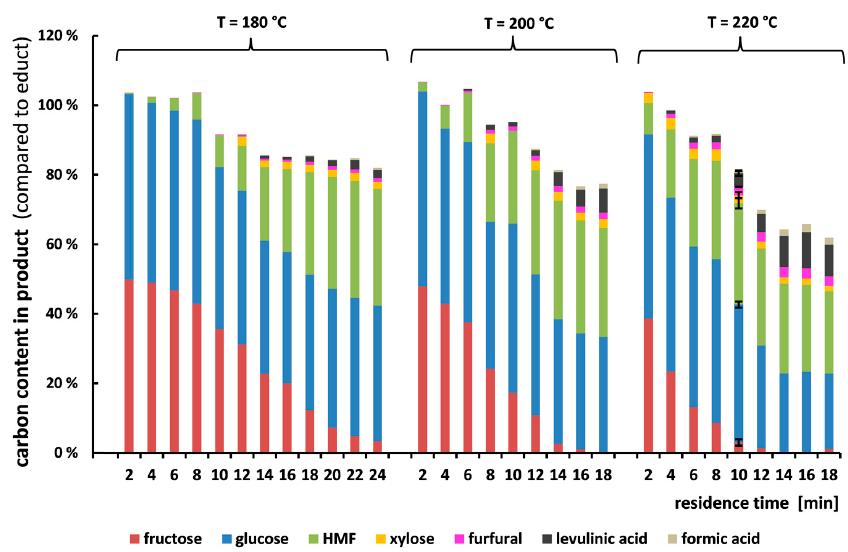
Figure 4. Carbon composition after acid-catalyzed conversion of sucrose at different residence times and reaction temperatures (T). The carbon input of sucrose is represented by 100%. Feedstock contained 2 wt % sucrose and 0.005 mol/L sulfuric acid.